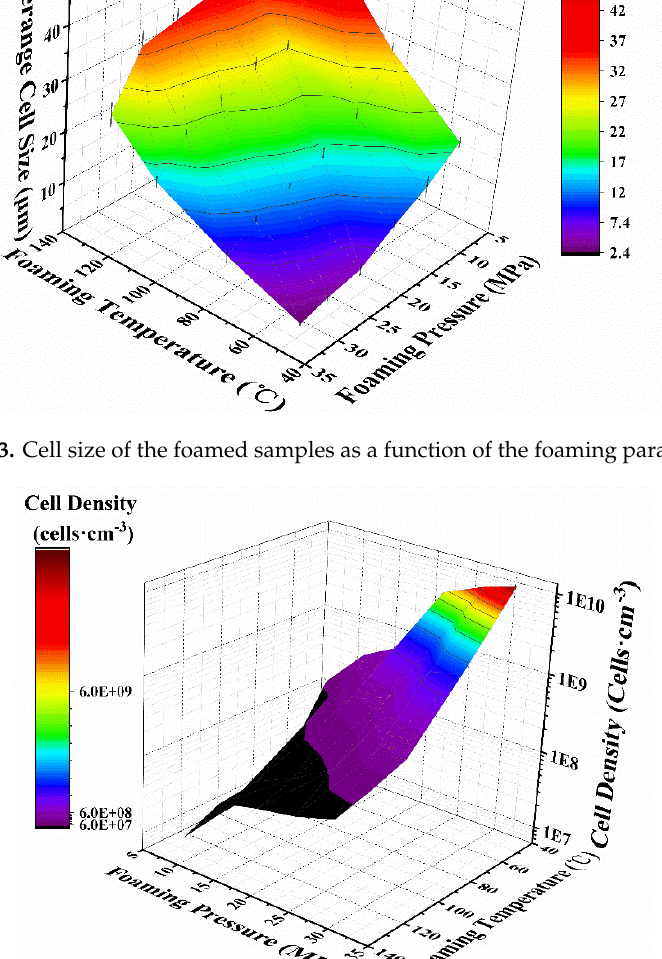
Figure 4. Cell density of the foamed samples as a function of the foaming parameters.